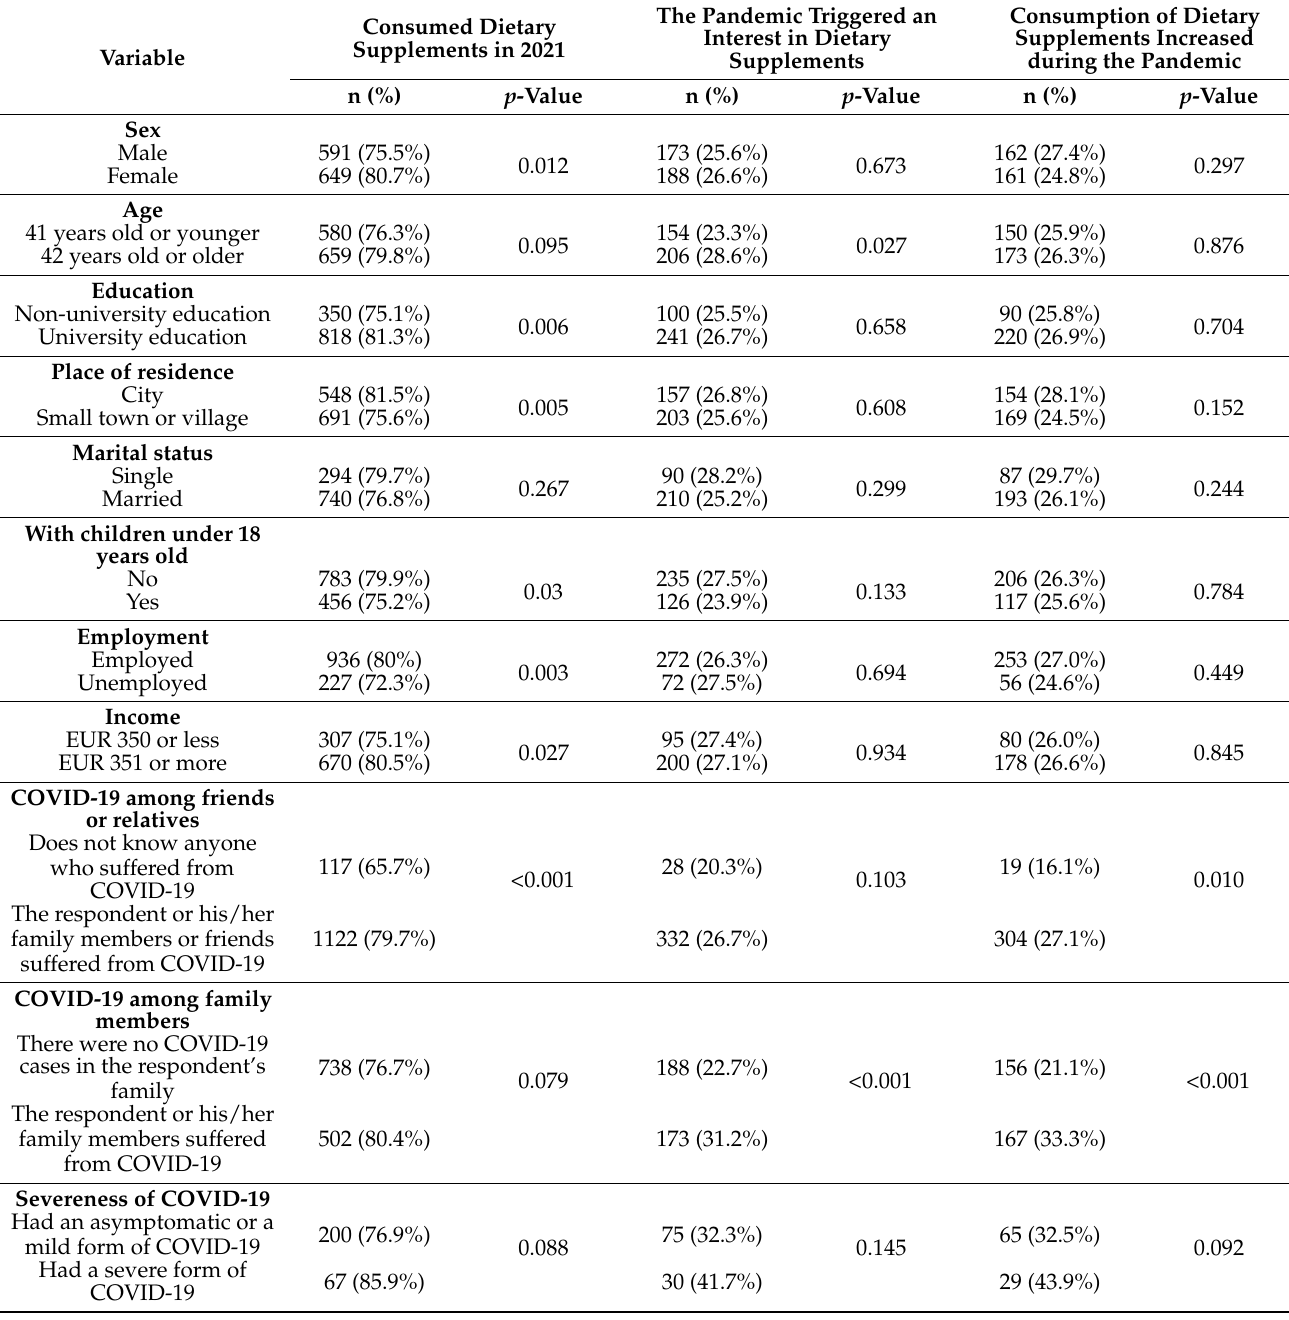
Table 5. Distribution of the respondents by consumption of dietary supplements, the impact of the COVID-19 pandemic on the consumption of dietary supplements, sociodemographic factors, and COVID-19